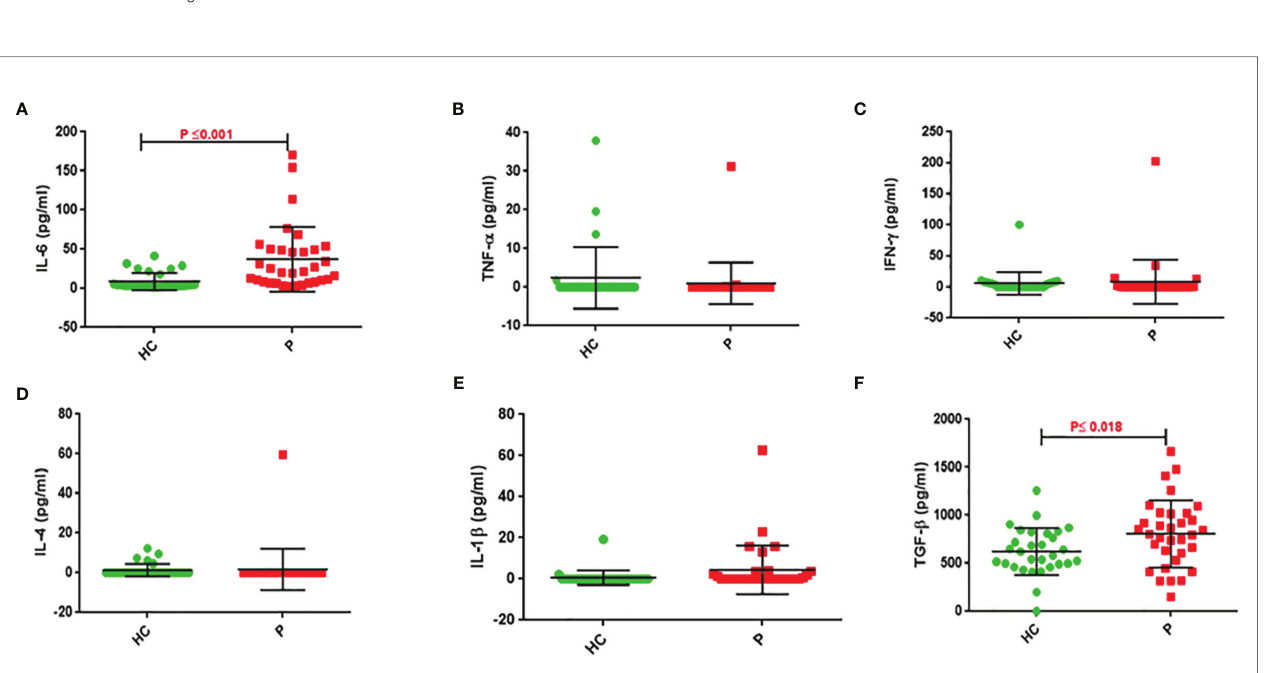
FIGURE 2 | Serum cytokine levels of patients compared to control group. Serum IL-6 (A) , TNF- a (B) , IFN- g (C) , IL-4 (D) , IL-1 b (E) , and TGF- b (F) concentrations in serum of NSCLC patients and healthy subjects. Serum levels of IL-6 and TGF- b in NSCLC patients are signi fi cantly higher than that of controls (P ≤ 0.001 and 0 ≤ 0.018,